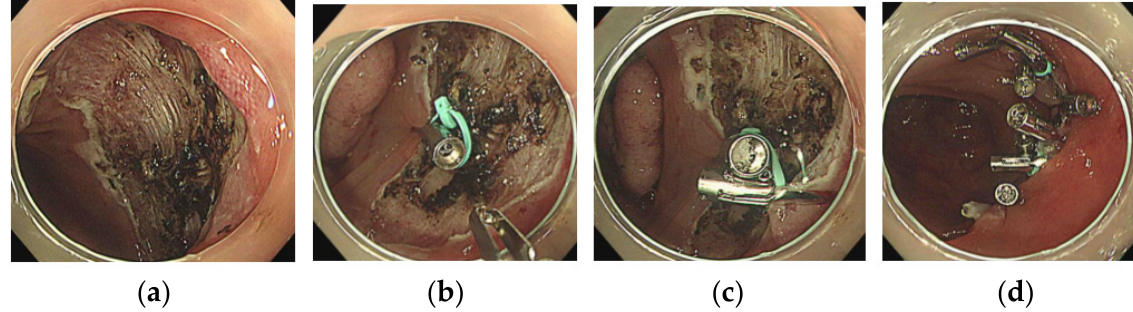
Figure 4. ( a ) A mid-transverse colon mucosal defect occurred subsequent to endoscopic submucosal dissection. ( b ) SureClip with the loop is delivered to the edge of the mucosal defect. ( c ) Another clip is placed on the opposite side of the mucosal defect and used to drag the loop. ( d ) Clips are added for complete and adequate closure of the mucosal defect.